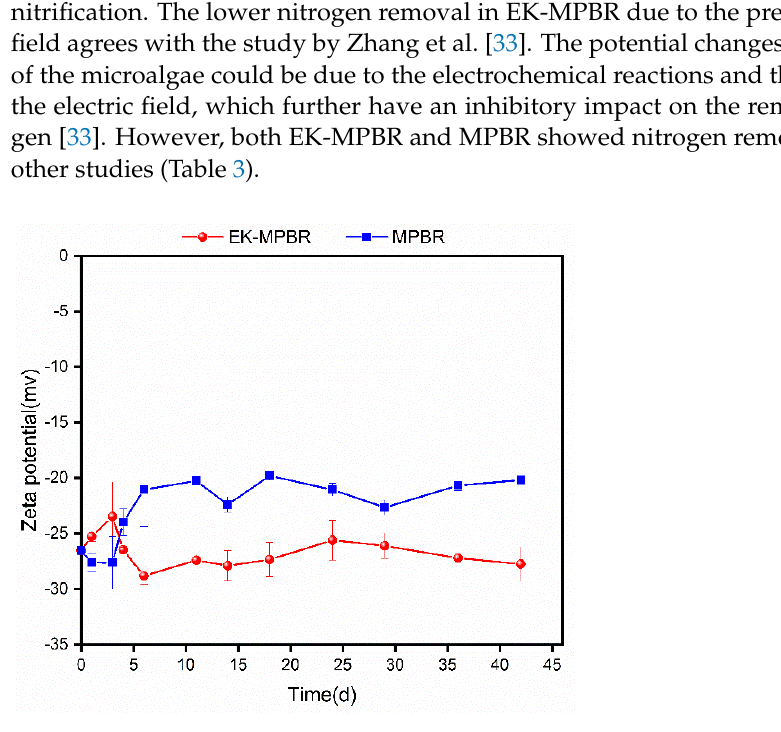
Figure 4. Zeta potential variation during EK-MPBR and MPBR operations. Table 3. The removal efficiency of MPBRs with Chlorella vulgaris .